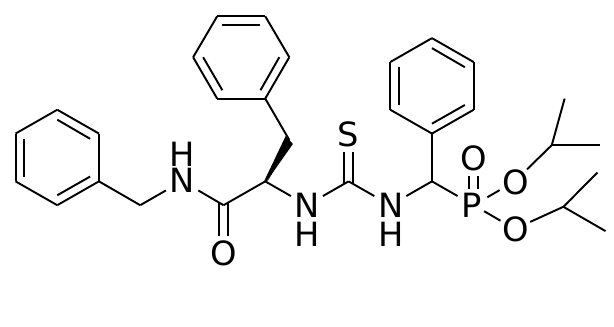
Figure 1. The molecular structure of